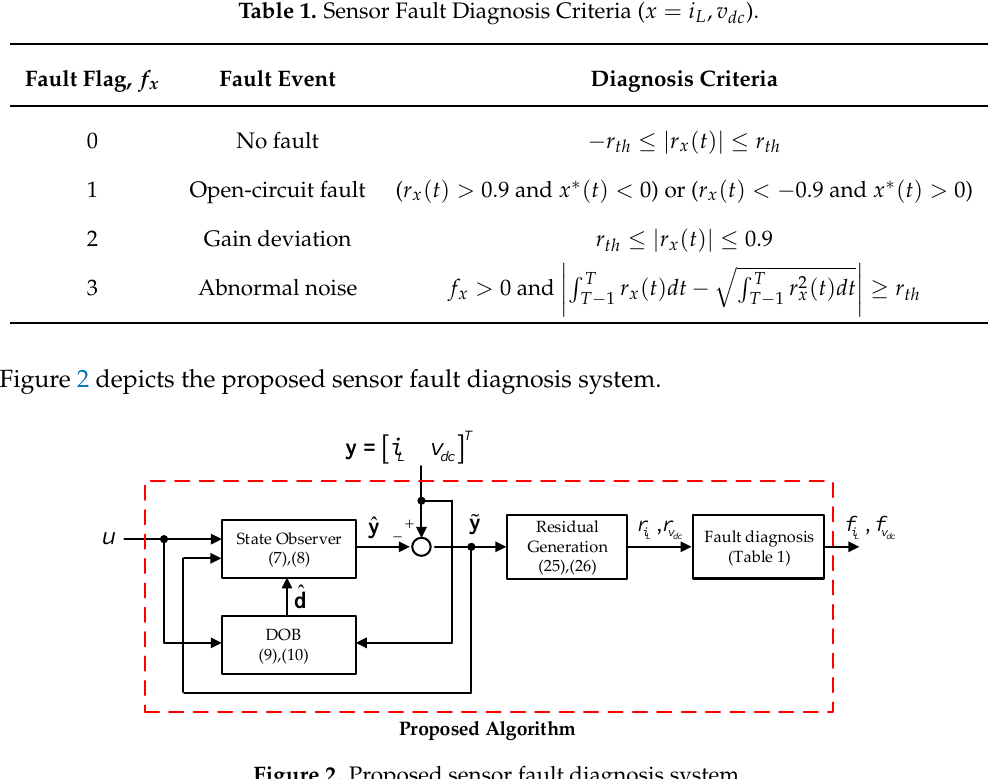
Figure 2. Proposed sensor fault diagnosis system.